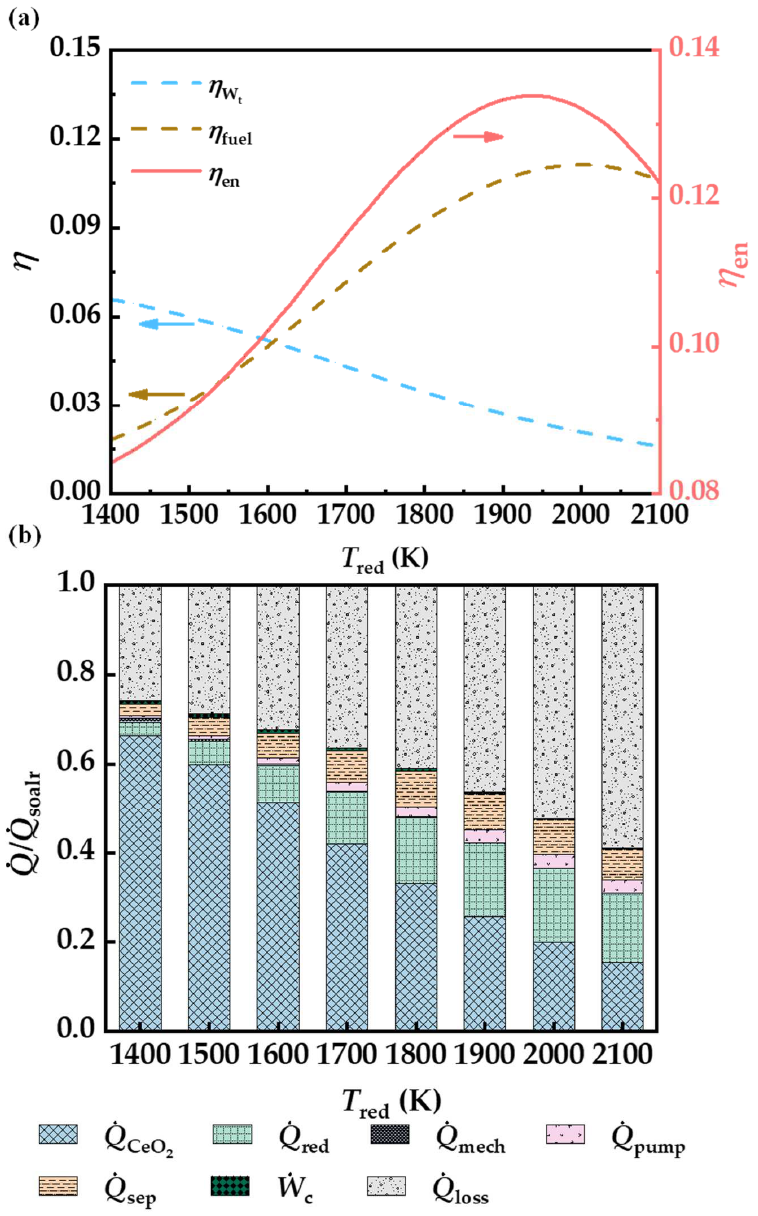
Figure 4. ( a ) Effect of T red on η fuel , η W ( T ox = 1300 K, P red = 10 − 4 bar, α = 0.95, ε gg = 0, P c,in = 75 bar, and P t,in = 200 bar).